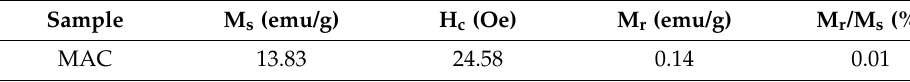
Figure 4. Patterns of the MAC properties: ( a ) VSM; ( b ) XRD; ( c ) FT-IR. Table 3. Magnetic parameters of MAC.